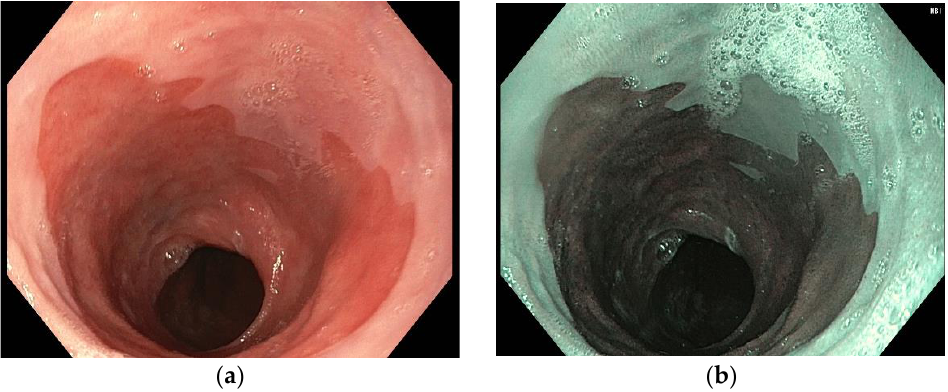
Figure 2. Endoscopic evaluation of circumferential Barrett’s Esophagus ( a ) in white light endoscopy; ( b ) in narrow band imaging vision (NBI).